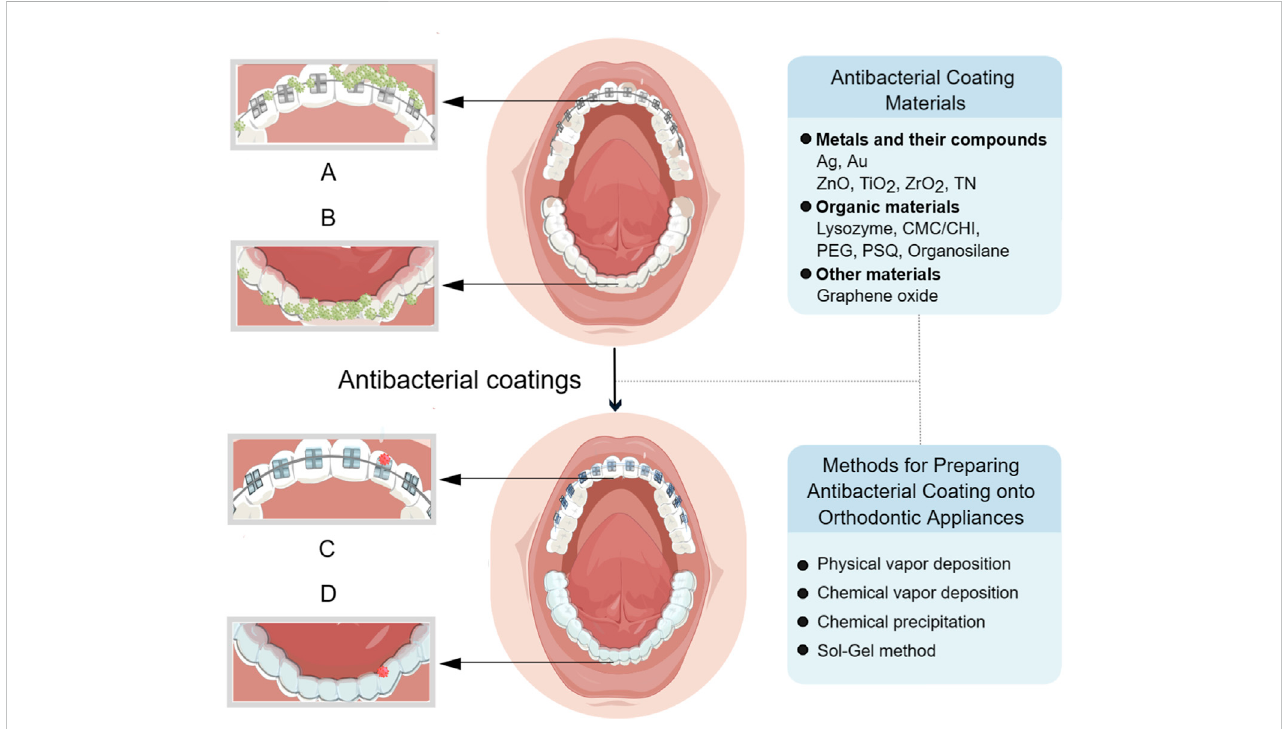
FIGURE 1 (A) Bacteria build up on the surface of fi xed appliance before the application of coating. (B) Bacteria build up on the surface of clear aligner before the application of coating. (C) Bacteria on the fi xed appliance are reduced after coating. (D) Bacteria on the clear aligner are reduced after coating. Created with